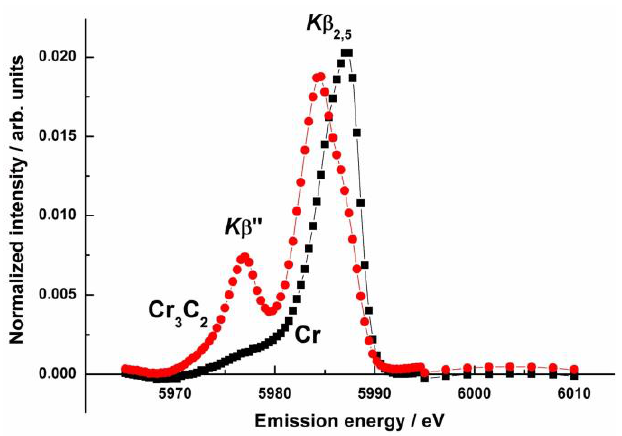
Figure 3. Normalized vtc X–ray emission spectra of metallic chromium and Cr3C2 carbide used in modeling experimental spectra of vtc X-ray of Cr–C samples. Reproduced from [5] with permission from Elsevier, 2018.